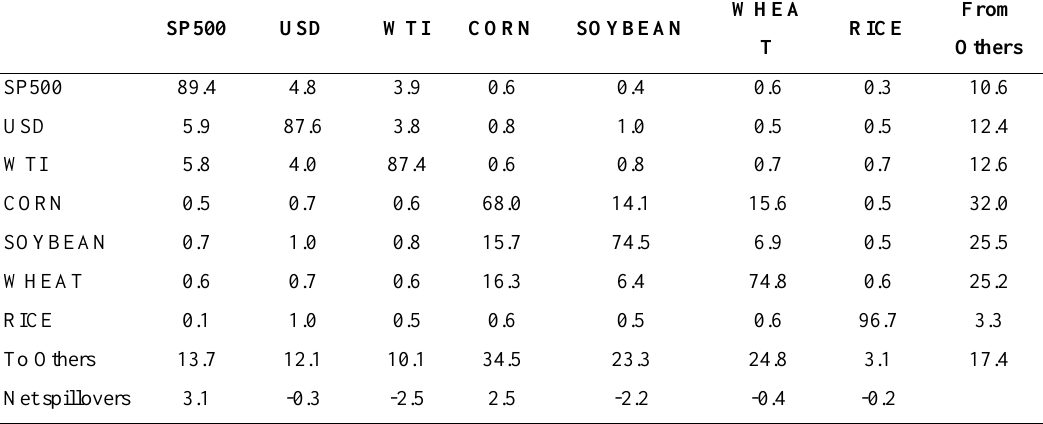
Table 2: The direction of implied volatility spillovers (the lasso method) SP500 USD WTI CORN SOYBEAN